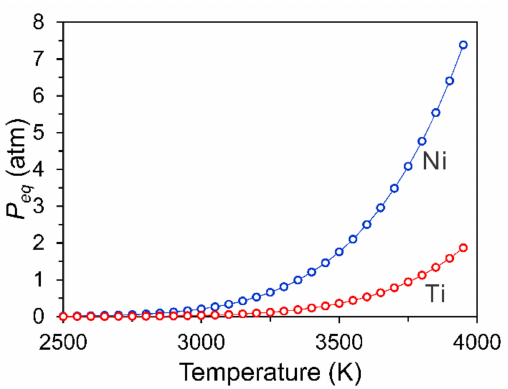
Figure 2. Equilibrium vapor pressures ( P eq ) of Ni and Ti over the liquid alloy for Ti-50.0 at % Ni alloy, which were calculated according to Ref.